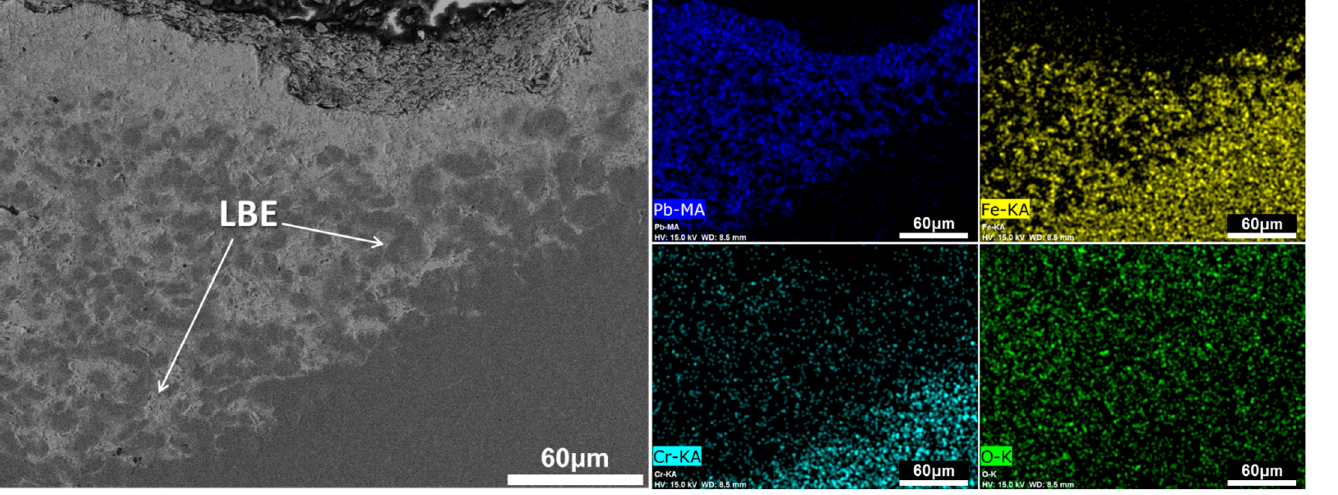
Figure 11. Severe LBE penetration on HT9 without oxide formation after 2000 h at 600 °C.